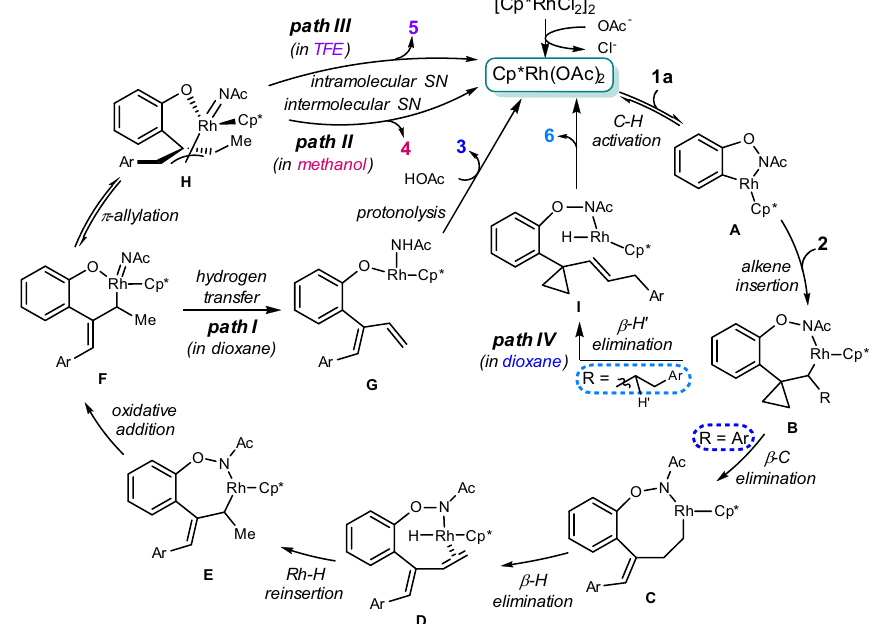
Fig. 10 Proposed reaction pathways. Solvent-controlled diversi fi ed C – H activation cascades involving selective β -C/ β -H elimination, π -allylation, inter-/ intramolecular nucleophilic substitution, and β -H ’ elimination processes were